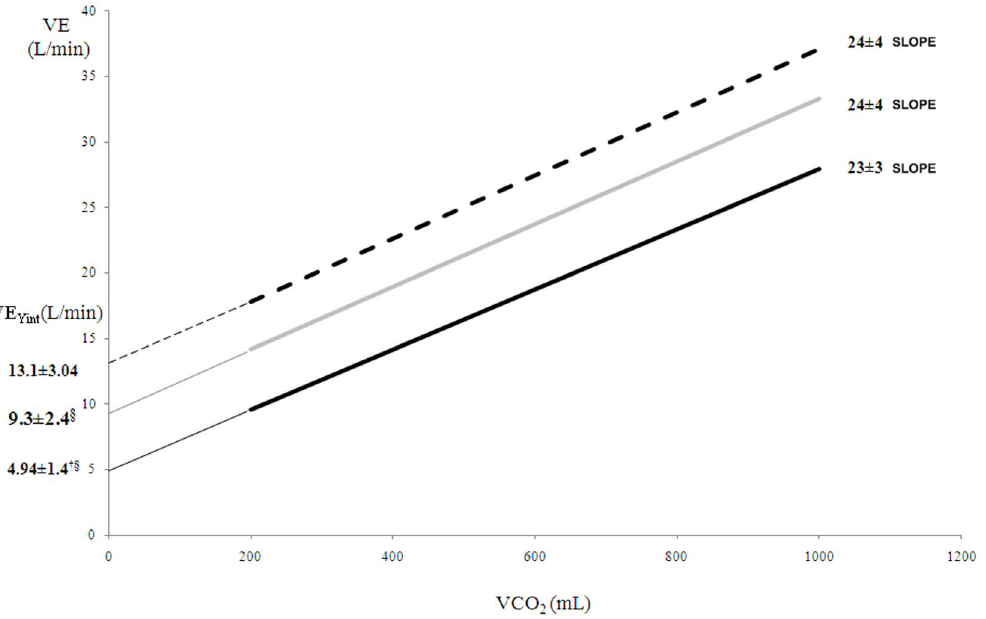
Figure 4. VE vs. VCO 2 relationship in healthy subjects with 0 mL (black line), 250 mL (grey line) and 500 mL (dotted line) of additional dead space (DS). The adding of DS upshifts the VE vs VCO 2 relationship without significant slope changes. { p , 0.001 versus + 250 mL; 1 p , 0.001 versus + 500 mL.